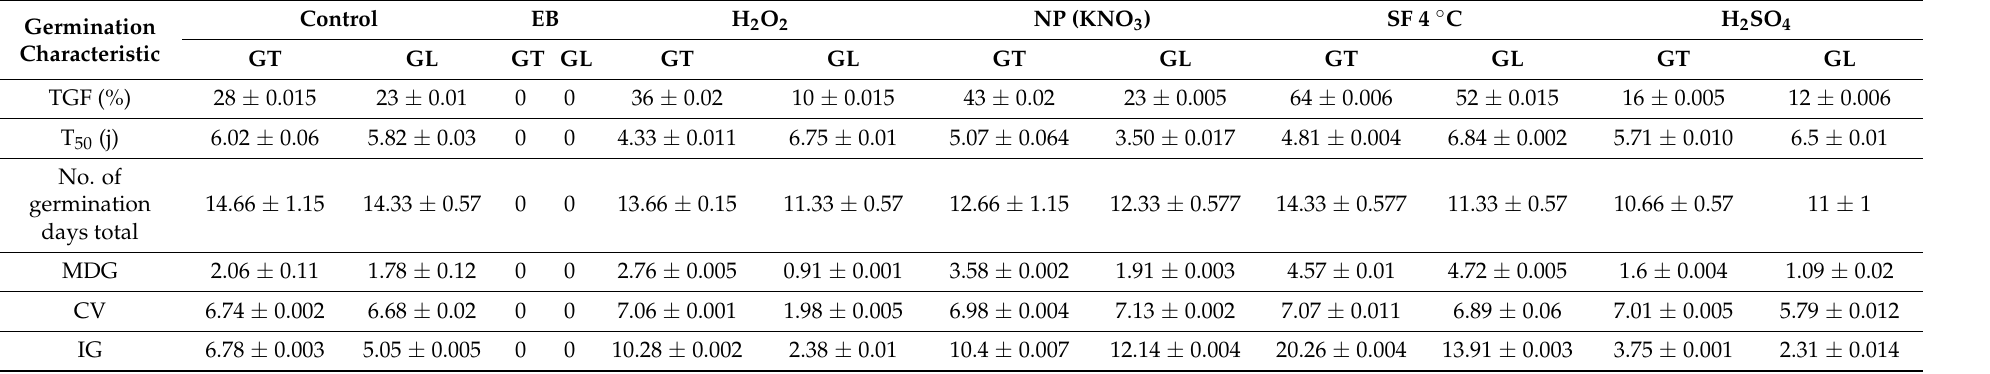
Table 6. Averages of the main germination parameters of A.P var. depressus seeds (GL: peripheral seeds; GT: central seeds) in soil, according to the different pre-treatments (EB: boiling water, H 2 O 2 oxygenated water, NP: potassium nitrate; SF 4 ◦ C: cold scarification 4 ◦ C; H 2 SO 4 : sulphuric